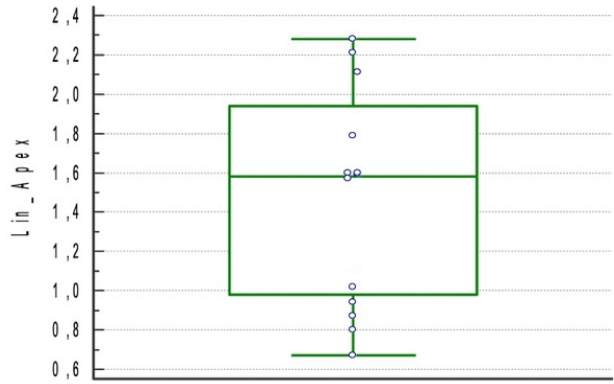
Figure 7. Boxplot for linear deviation at apex point of the included studies. No statistically significant correlations were found between linear (at shoulder and at apex points) deviations and angular deviations (correlation coefficient 0.35 and 0.27, respectively). A statistically significant correlation was found between linear deviations at shoulder and at apex point (correlation coefficient 0.91) that can be summarized by the regression equation y = 0.03080 + 0.8254 x (Figure 8).